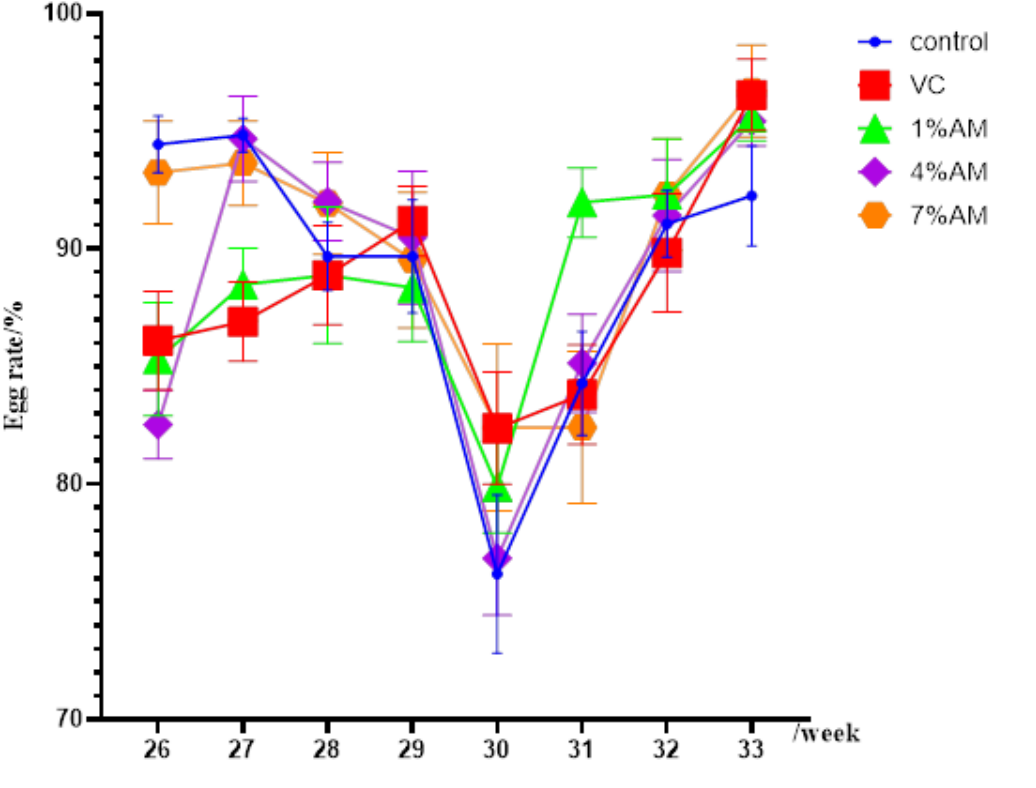
Figure 7. Effect of feed AM supplementation on egg production rate of laying hens at 25–33 weeks during peak laying period. Table 4. Effects of AM on production performance and egg quality of laying hens.